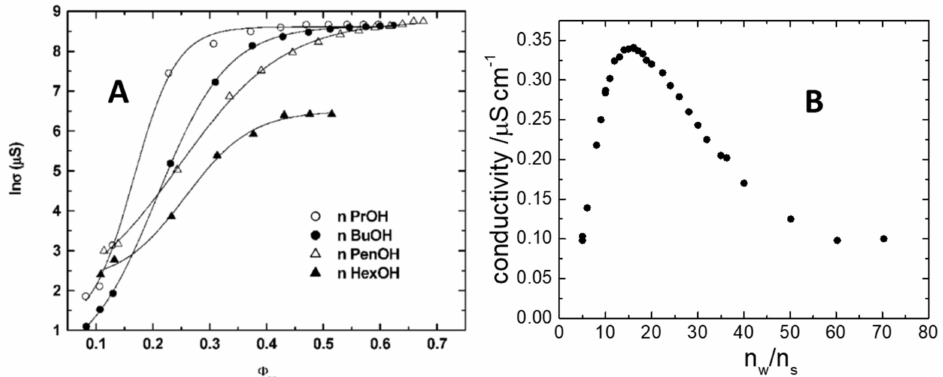
Figure 3. ( A ) Dependence of the logarithm of conductivity on the water volume fraction for the w / o µ E water / SDS + Myrj 45 / cyclohexane in the presence of di ff erent alcohols at 30 ◦ C. Reprinted with permission from [26]. Copyright (2004) American Chemical Society. ( B ) Conductivity as a function of the water / surfactant molar ratio for the w / o µ E water / CTAB / pentanol / hexane. Adapted with permission from [22]. Copyright (1996) American Chemical